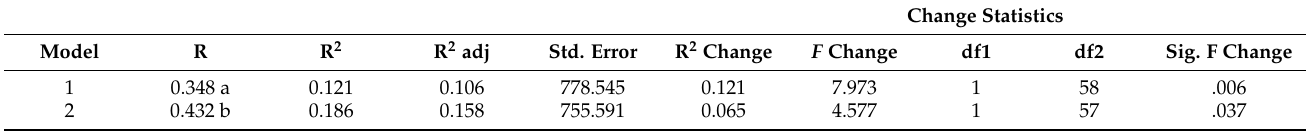
Table A3. Model summary for word RTs at T2.